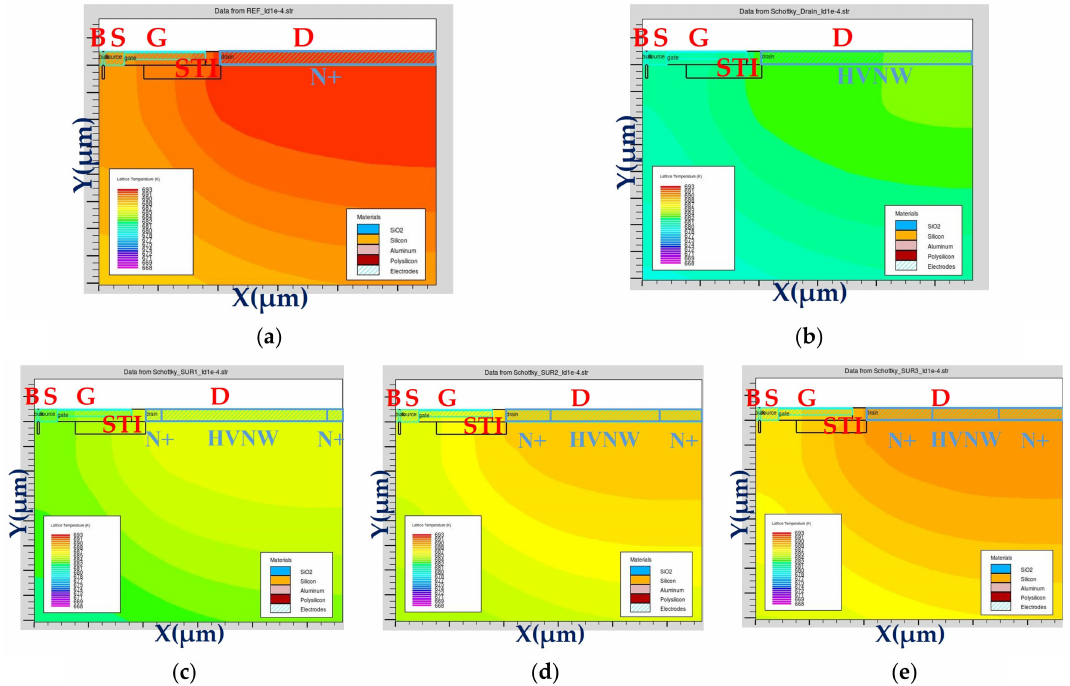
Figure 22. Lattice temperature diagrams of; ( a ) Reference; ( b ) Schottky_Drain; ( c ) Schottky_SUR1; ( d ) Schottky_SUR2; and ( e ) Schottky_SUR3 at I d = 1 × 10 − 4 A injection